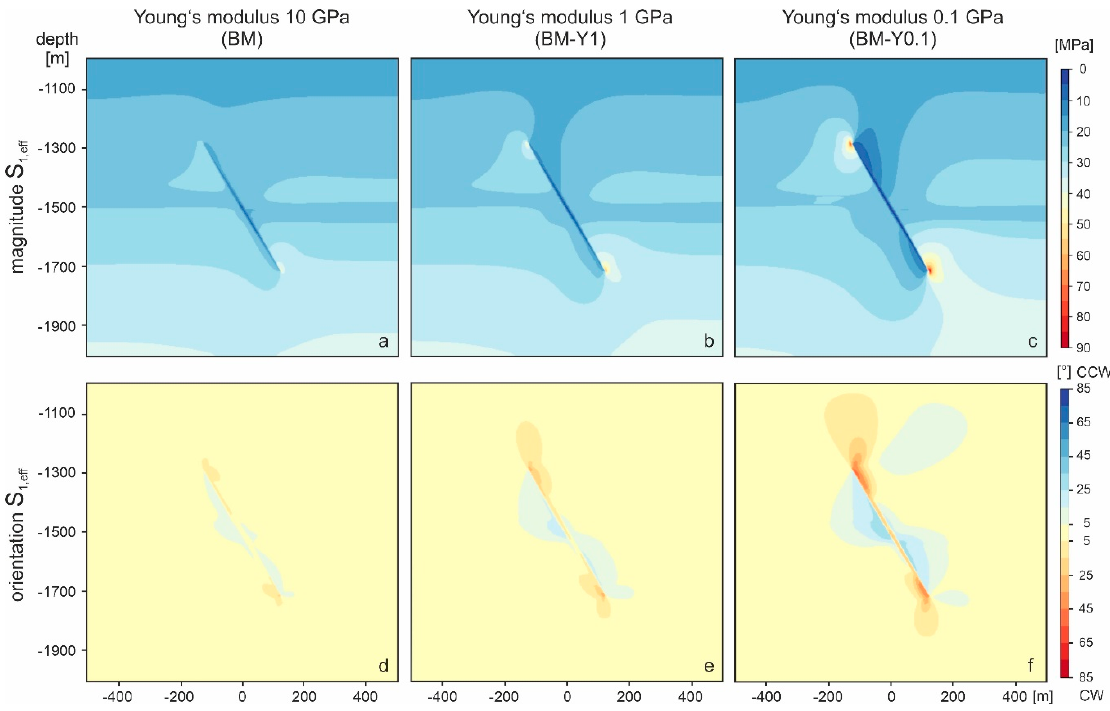
Figure 4. Spatial variations in the magnitude ( a – c ) and orientation (deviation from vertical; d – f ) of the effective maximum principal stress (S 1,eff ) after five years of injection for three different Young’s modulus values assigned to the fault zone.